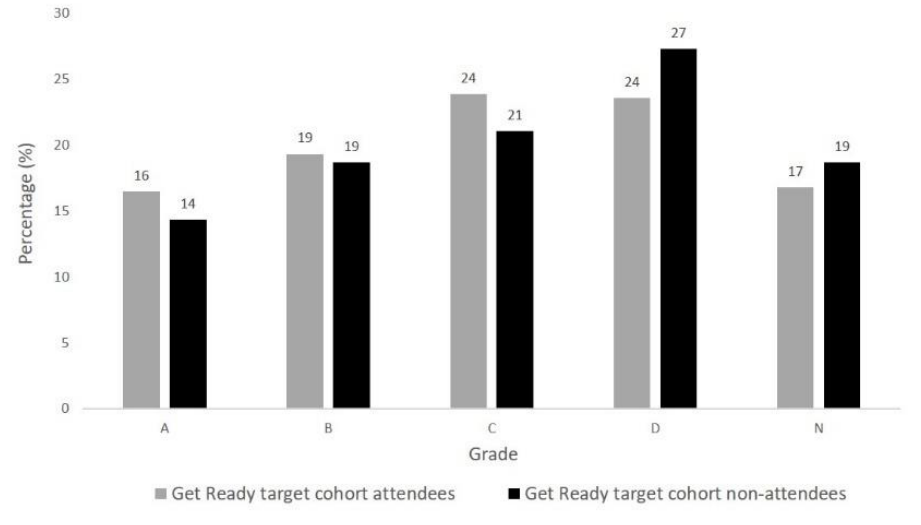
Performance of target cohort Get Ready attendees vs. non-attendees